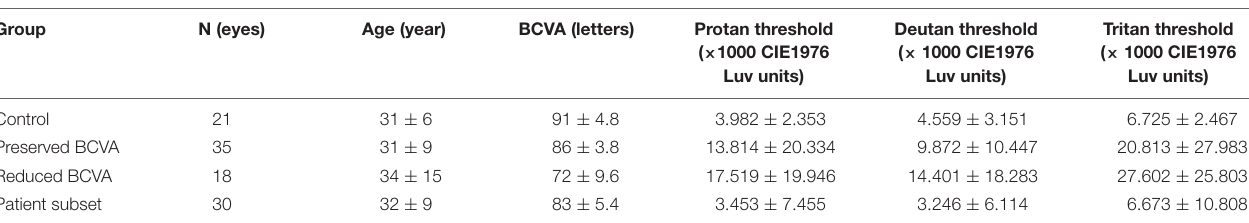
FIGURE 1 | (A) Farnsworth-Munsell 100 Hue color vision test. (B) Simulation of visual field loss restricting the view of the test resulting in slow test times. (C) Cambridge color test (CCT) target. (D) Low vision version of the CCT showing four circles across the screen, providing an easier target for patients with low vision and reduced visual field. (E) Example output from full CCT version, producing an ellipse in color vision function in color space. (F) Example output from trivector test showing outputs for the protan, deutan, and tritan axes. TABLE 1 | Summary characteristics of patient